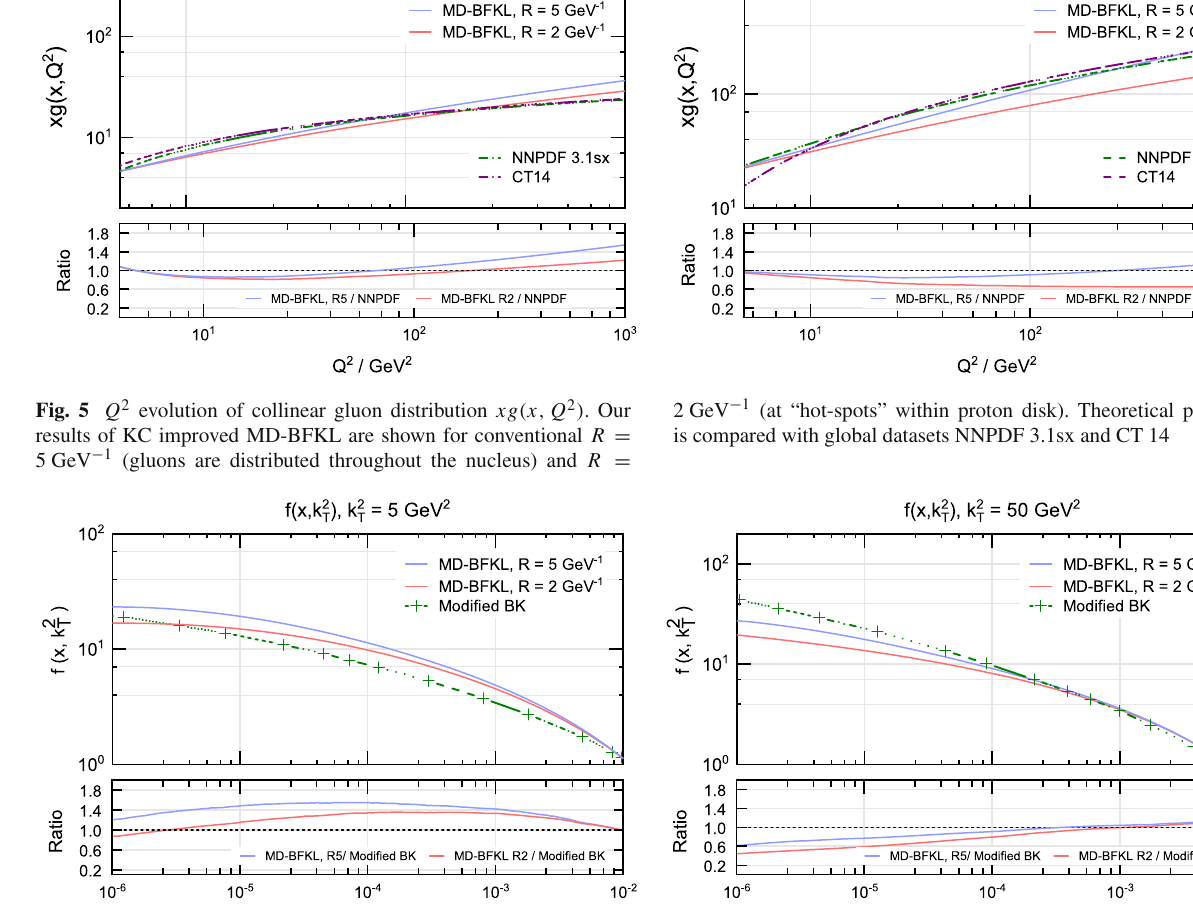
) . Our results of KC improved MD-BFKL are shown for conventional R = 5 GeV − 1 Fig. 6 x evolution of unintegrated gluon distribution f ( x , k 2 T (gluons are distributed throughout the nucleus) and R = 2 GeV − 1 (at “hot-spots” within proton disk). Prediction from modified BK equation is plotted for